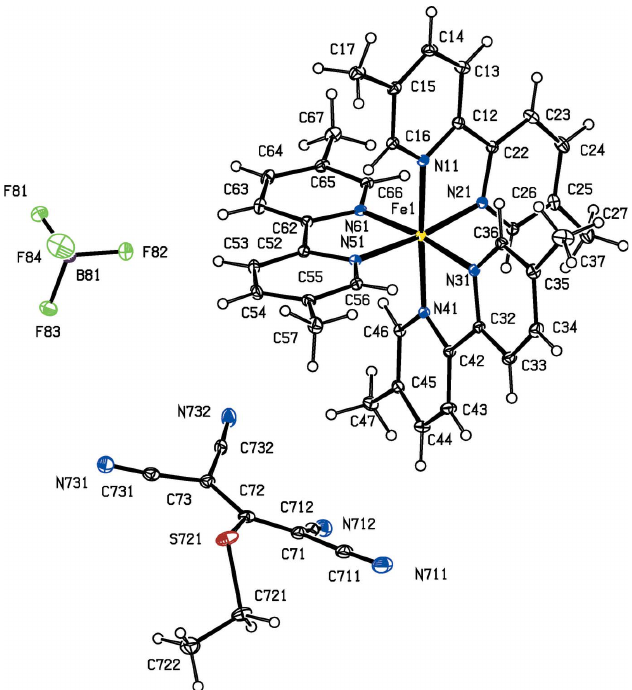
Figure 5 The independent ionic components in compound (V), showing the atom- labelling scheme. Displacement ellipsoids are drawn at the 30% probability level.